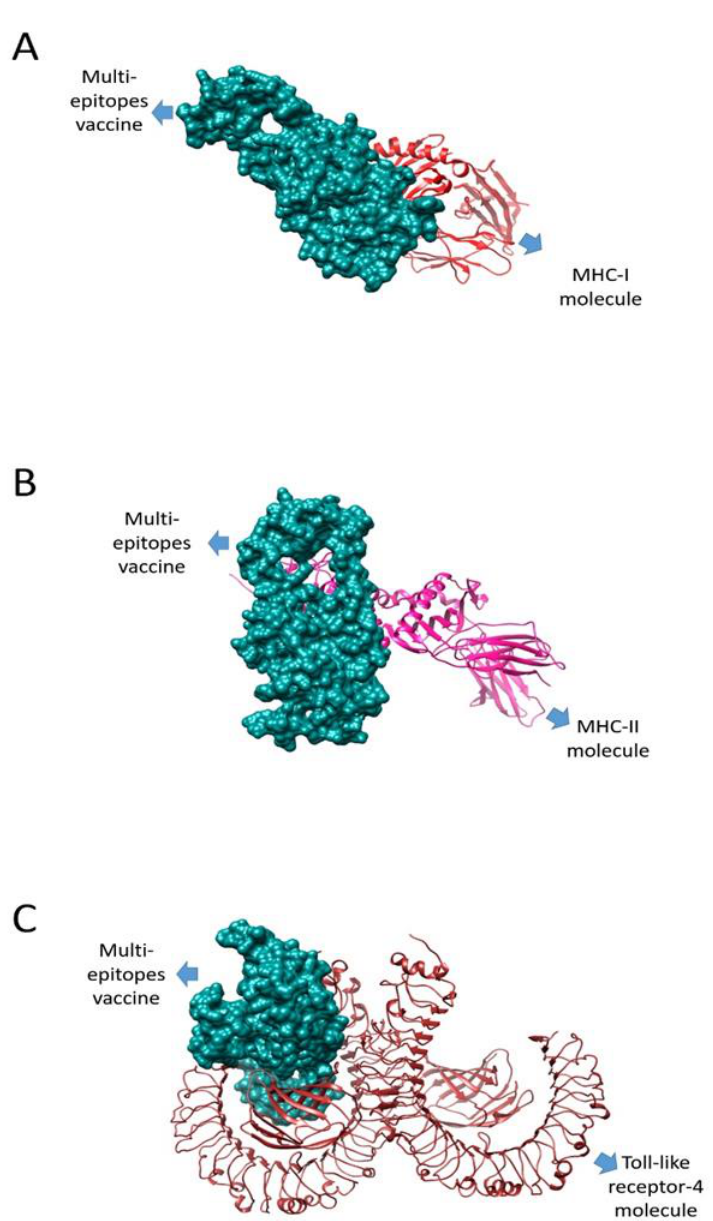
Figure 8. Intermolecular docked complexes of the vaccine with the MHC-I ( A ), MHC-II ( B ), and TLR-4 ( C ) molecules.